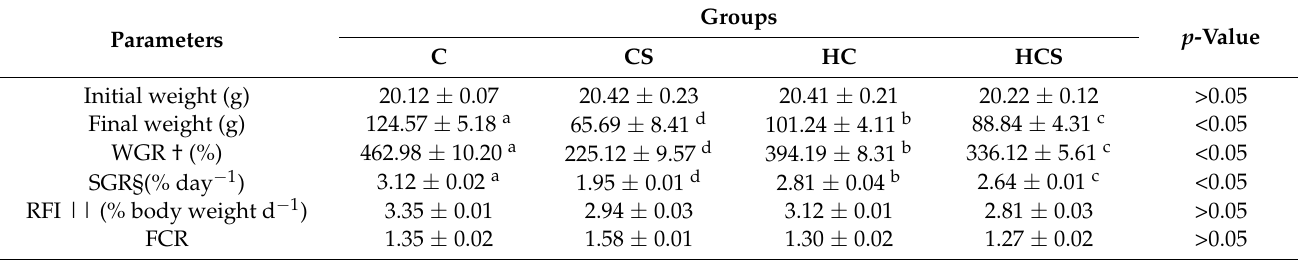
Table 3. Growth performance and feed utilization of blunt snout bream subjected to different treatments.